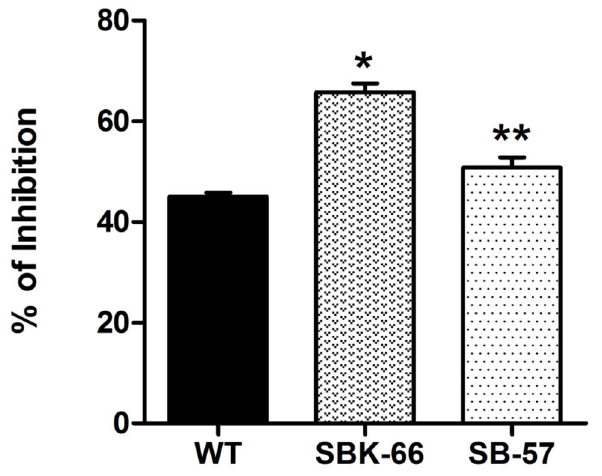
Figure 5. Inhibitory effect of rice-produced rhIGFBP-3 on MCF-7 human breast cancer cells. (A) Equal amount (3.125 mg seed) of WT, SB and SBK total seed protein extracts were added to the MCF-7 cells separately. Data are shown as means ± SD. * p < 0.05 and ** p < 0.01 denote statistically significant and very significant differences, respectively, between transgenic lines and WT.